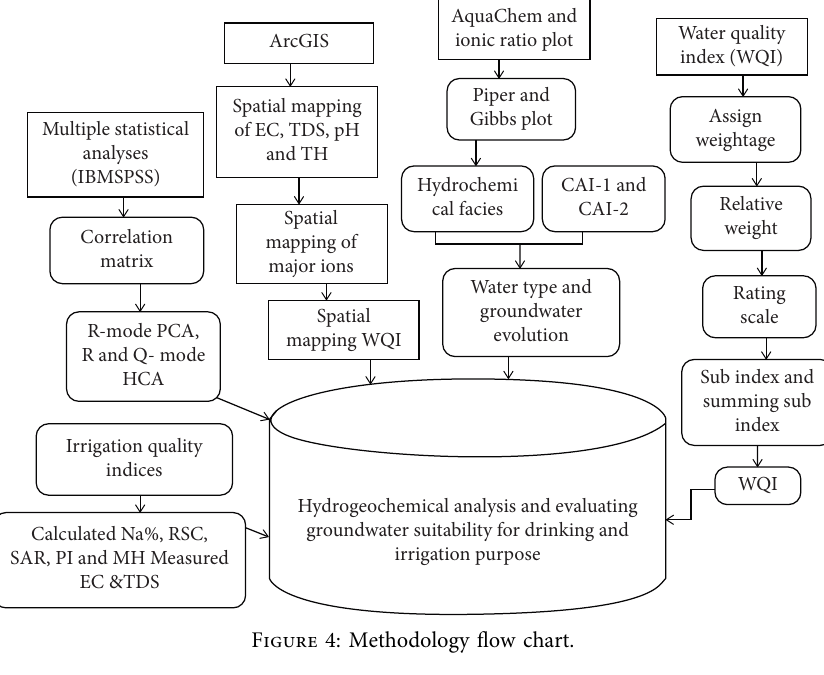
Figure 4: Methodology fow